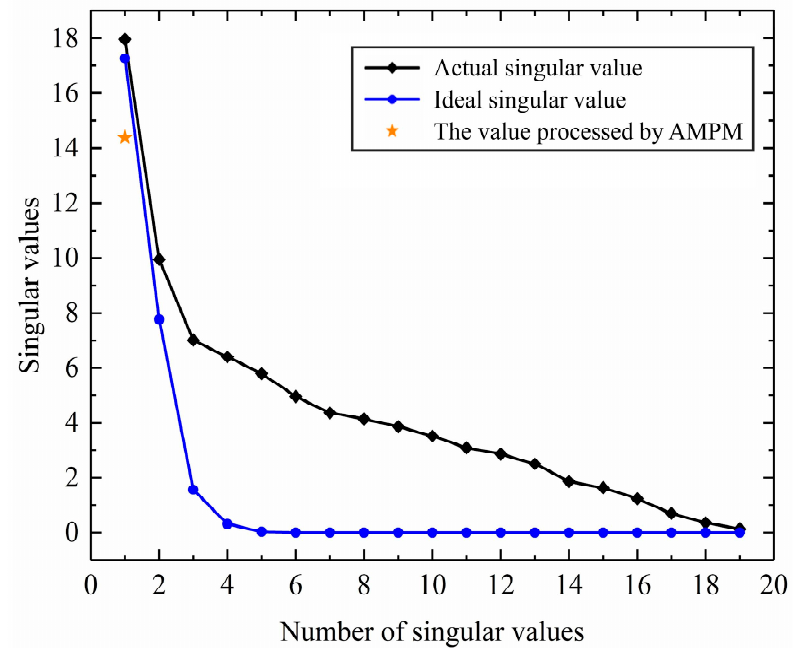
Figure 1. Singular values distribution.